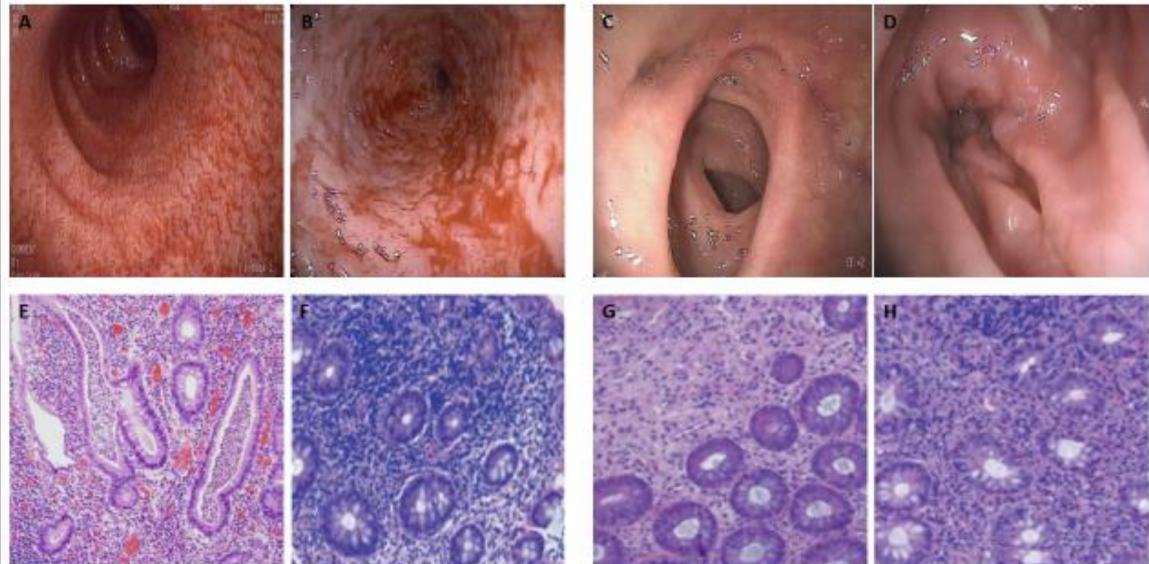
Figure 4. Endoscopic and histopathological findings of diversion colitis. ( A – B ): Pre-stimulation colonoscopy showed easily hemorrhagic mucosa, with edema, spontaneous bleeding, erythema and stenosis ( B ). ( C – D ): Biopsies after probiotics stimulation demonstrated only low-grade inflammation and edema, with diffuse erythema ( D ), without erosions and friability mucous. ( E – F ): Pre-stimulation histopathological evaluation of colon biopsies with hematoxylin and eosin staining showed inflammation with lymphoplasmocytic infiltration, follicular lymphoid hyperplasia, crypt abscesses, and crypt architecture distortion. ( G – H ): Biopsies after probiotics stimulation demonstrated a low-grade inflammation with reduced crypt abscesses, lymphoplasmocytic infiltration, follicular lymphoid hyperplasia, and crypt architecture